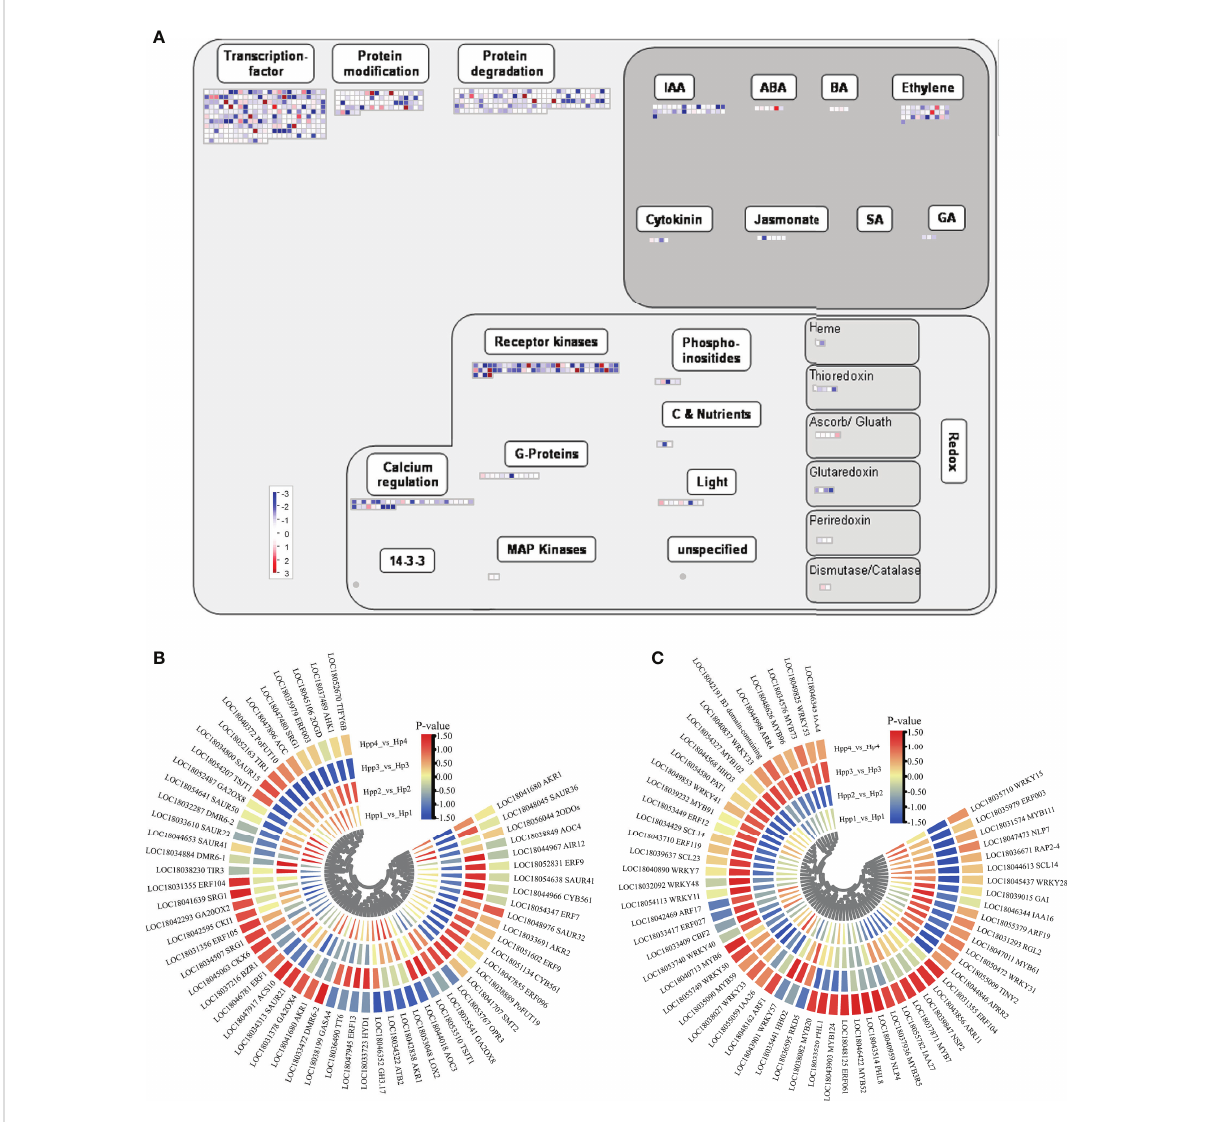
FIGURE 6 Plant Hormone-Related and Transcription-Regulating differentially expressed genes (DEGs) between Harumi/Hongjv (HP) and Harumi/Ponkan/ Hongjv (HPP) fruits. (A) MapMan-based “ regulatory-overview map ” of differentially expressed genes (DEGs) (Harumi/Hongjv (HP) group vs Harumi/Ponkan/Hongjv (HPP) group). The small heat map in each section of the fi gure shows the DEGs mapped to the pathway, with a small square indicating a gene. The color of the square indicates the expression of that gene, with blue indicating downregulation and red indicating upregulation. (B) Phytohormone-related genes. (C) Transcription factor (TF)-related genes, where red and blue represent upregulated and downregulated TF genes,